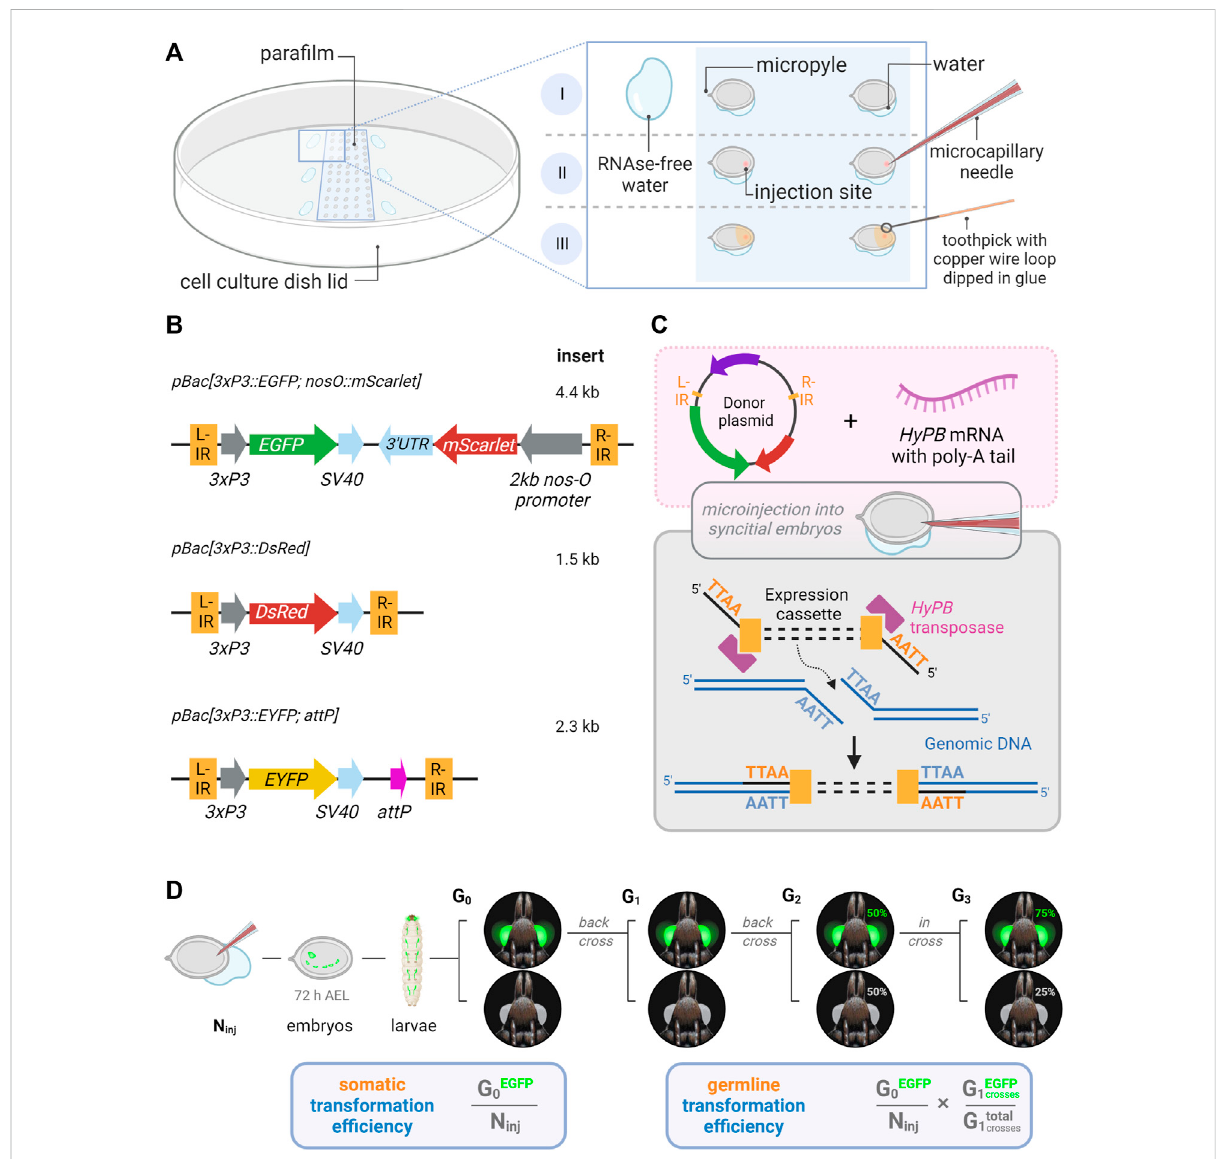
FIGURE 1 Microinjection procedure and transgenic constructs for the testing of hyperactive piggyBac transformation in Plodia . (A) Microinjection of P. interpunctella syncytial embryos. Gravid females oviposit en masse after CO 2 narcosis, and eggs are collected and oriented on a para fi lm strip in a tissue culture dish. A wet brush is used to position eggs, with water contact helping fi rm adhesion to the para fi lm ( I ). Microinjection is performed on the side opposite to the micropyle ( II ). Peripheral droplets of water are used to periodically fl ush the injection capillary of yolk. Eggs are sealed with glue following injection ( III ). (B) Expression cassettes of donor plasmids carrying 3xP3 eye and glia fl uorescent markers. IR = piggyBac internal repeats (L, left; R, right). (C) Transposon-mediated random integration following the injection of donor plasmid and hyPBase mRNA. (D)